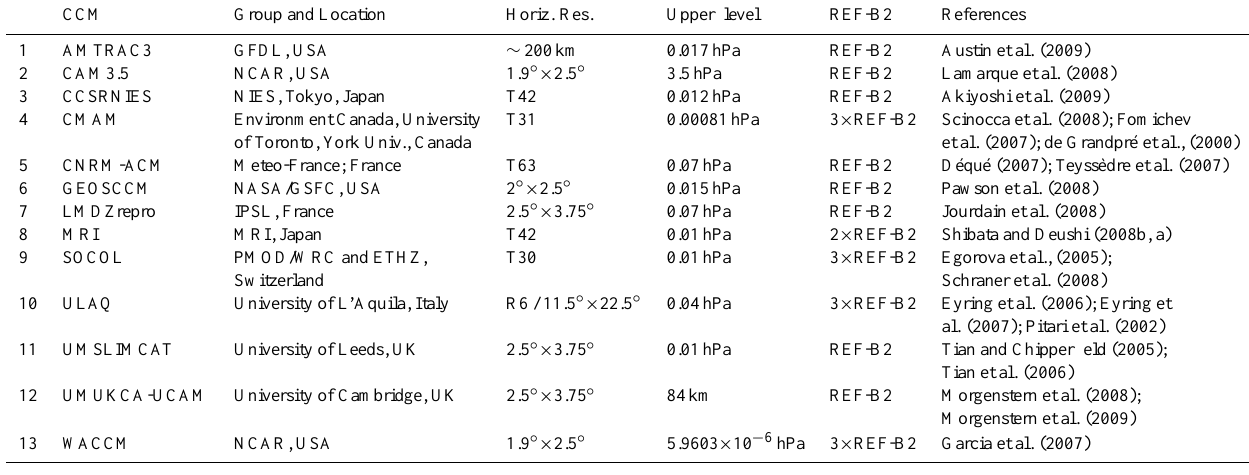
Table 2. Stratospherically resolving chemistry-climate models (CCMs) that are included in the multi-model mean stratospheric ozone projections in this database.